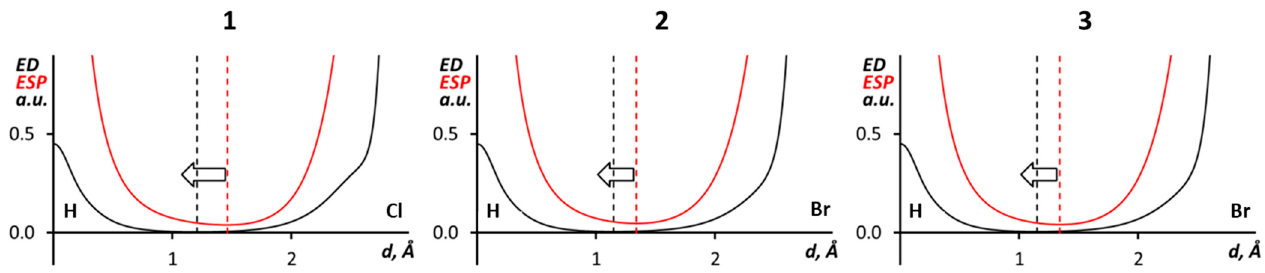
Figure 6. The ED and ESP 1D profiles along the H ∙∙∙ X bond paths for the ( 1 ) 2 (left), ( 2 ) 2 (middle), and ( 3 ) 2 (right) dimeric clusters of type I.